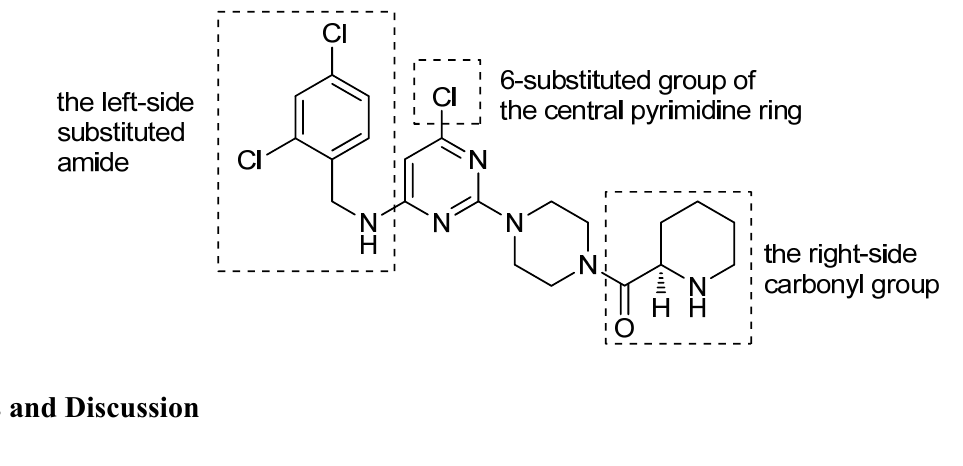
Figure 1. Structure of the compound 1 and the initial strategy for exploring the